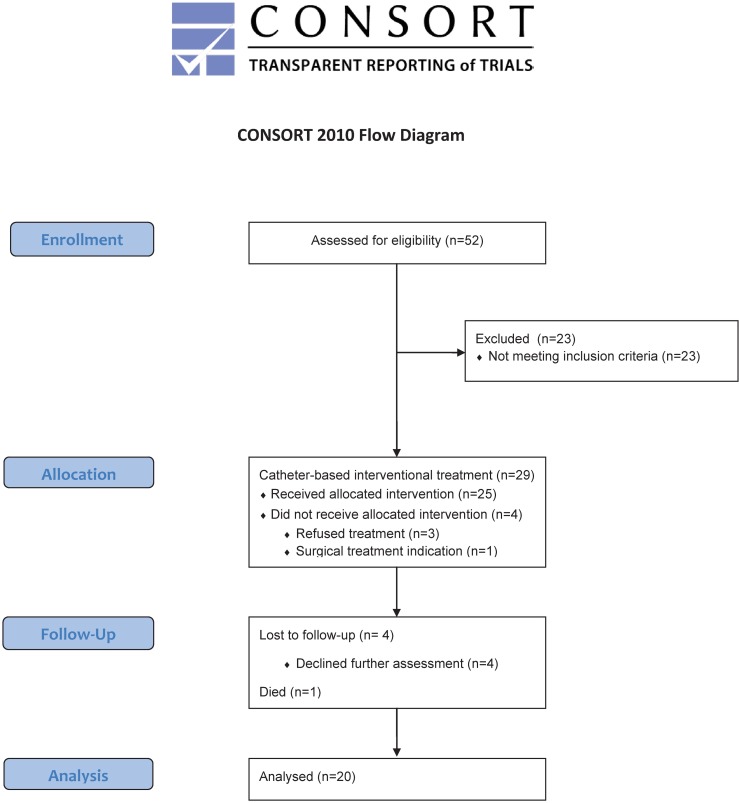
Study flow diagram.Flow of participants through the study.